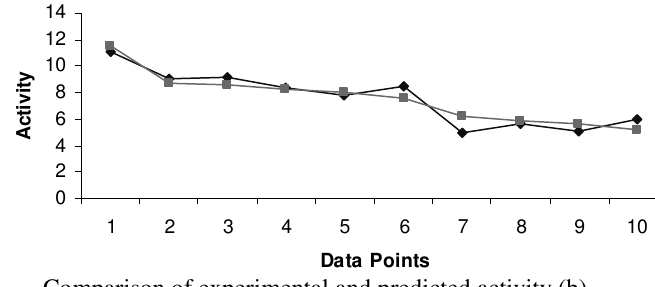
Figure 1 . (a) Scatter plot of experimental activity (-log Ki) verses Docking Score. (b) Comparison plot of experimental activity (in blue) verses Predicted activity (in